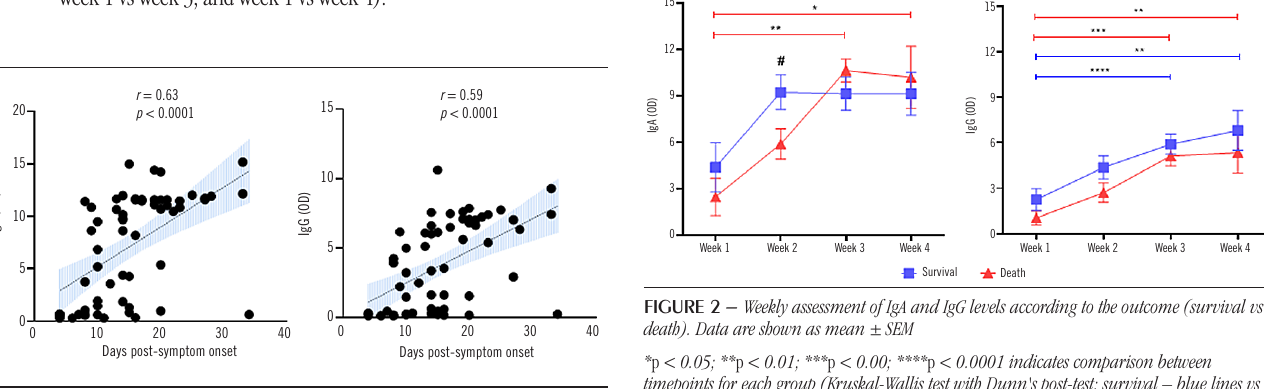
FIGURE 1 – Correlation between serum levels of IgA and IgG and days after the onset of symptoms. Spearman’s coefficients ( r ) were